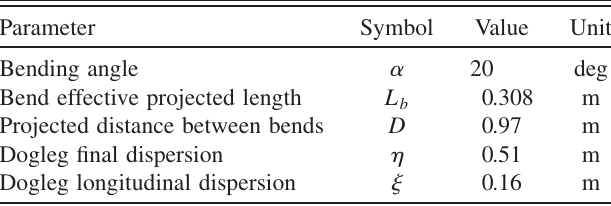
TABLE I. Geometric parameters and properties associated to the EEX beam line considered in this paper; see also Fig. 1.